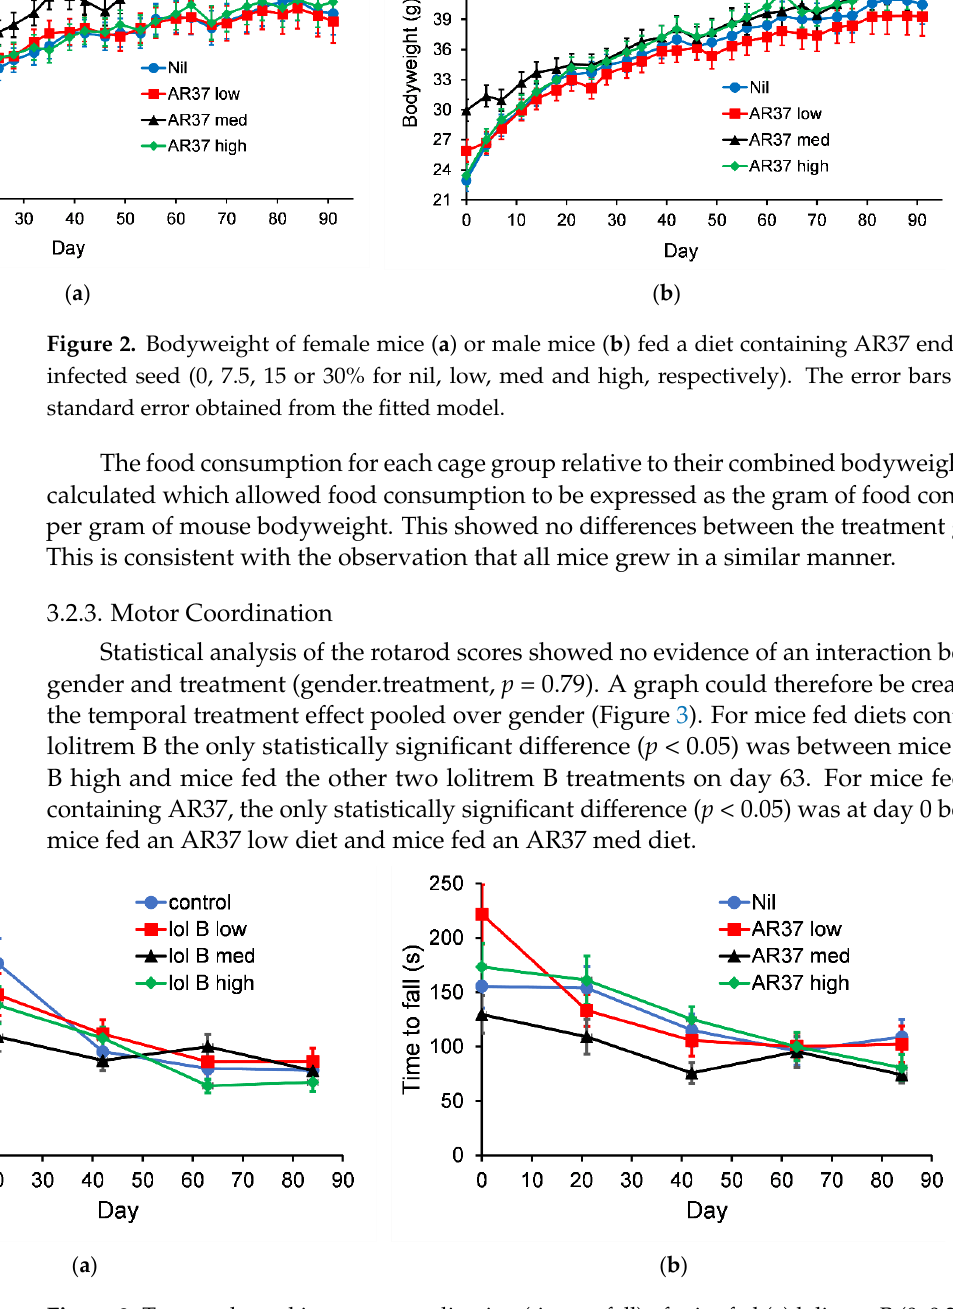
Figure 1. Bodyweight of female mice ( a ) or male mice ( b ) fed diet containing lolitrem B (0, 0.265, 0.53 or 1.06 ppm for control, low, med and high, respectively). The error bars are the standard error obtained from the fitted model.